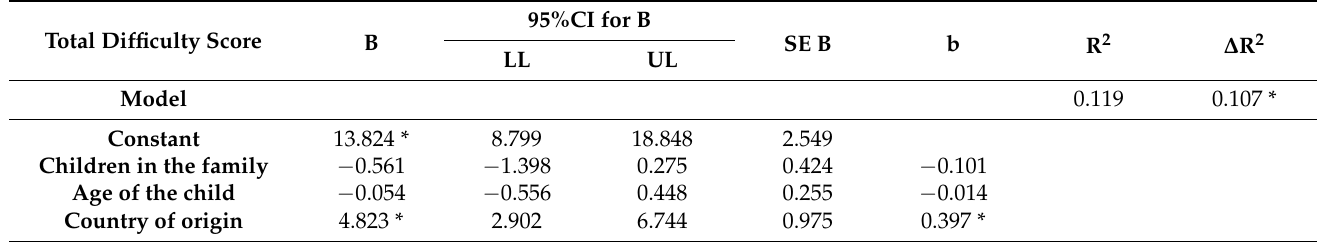
Table A6. Multiple regression results for total difficulty score.